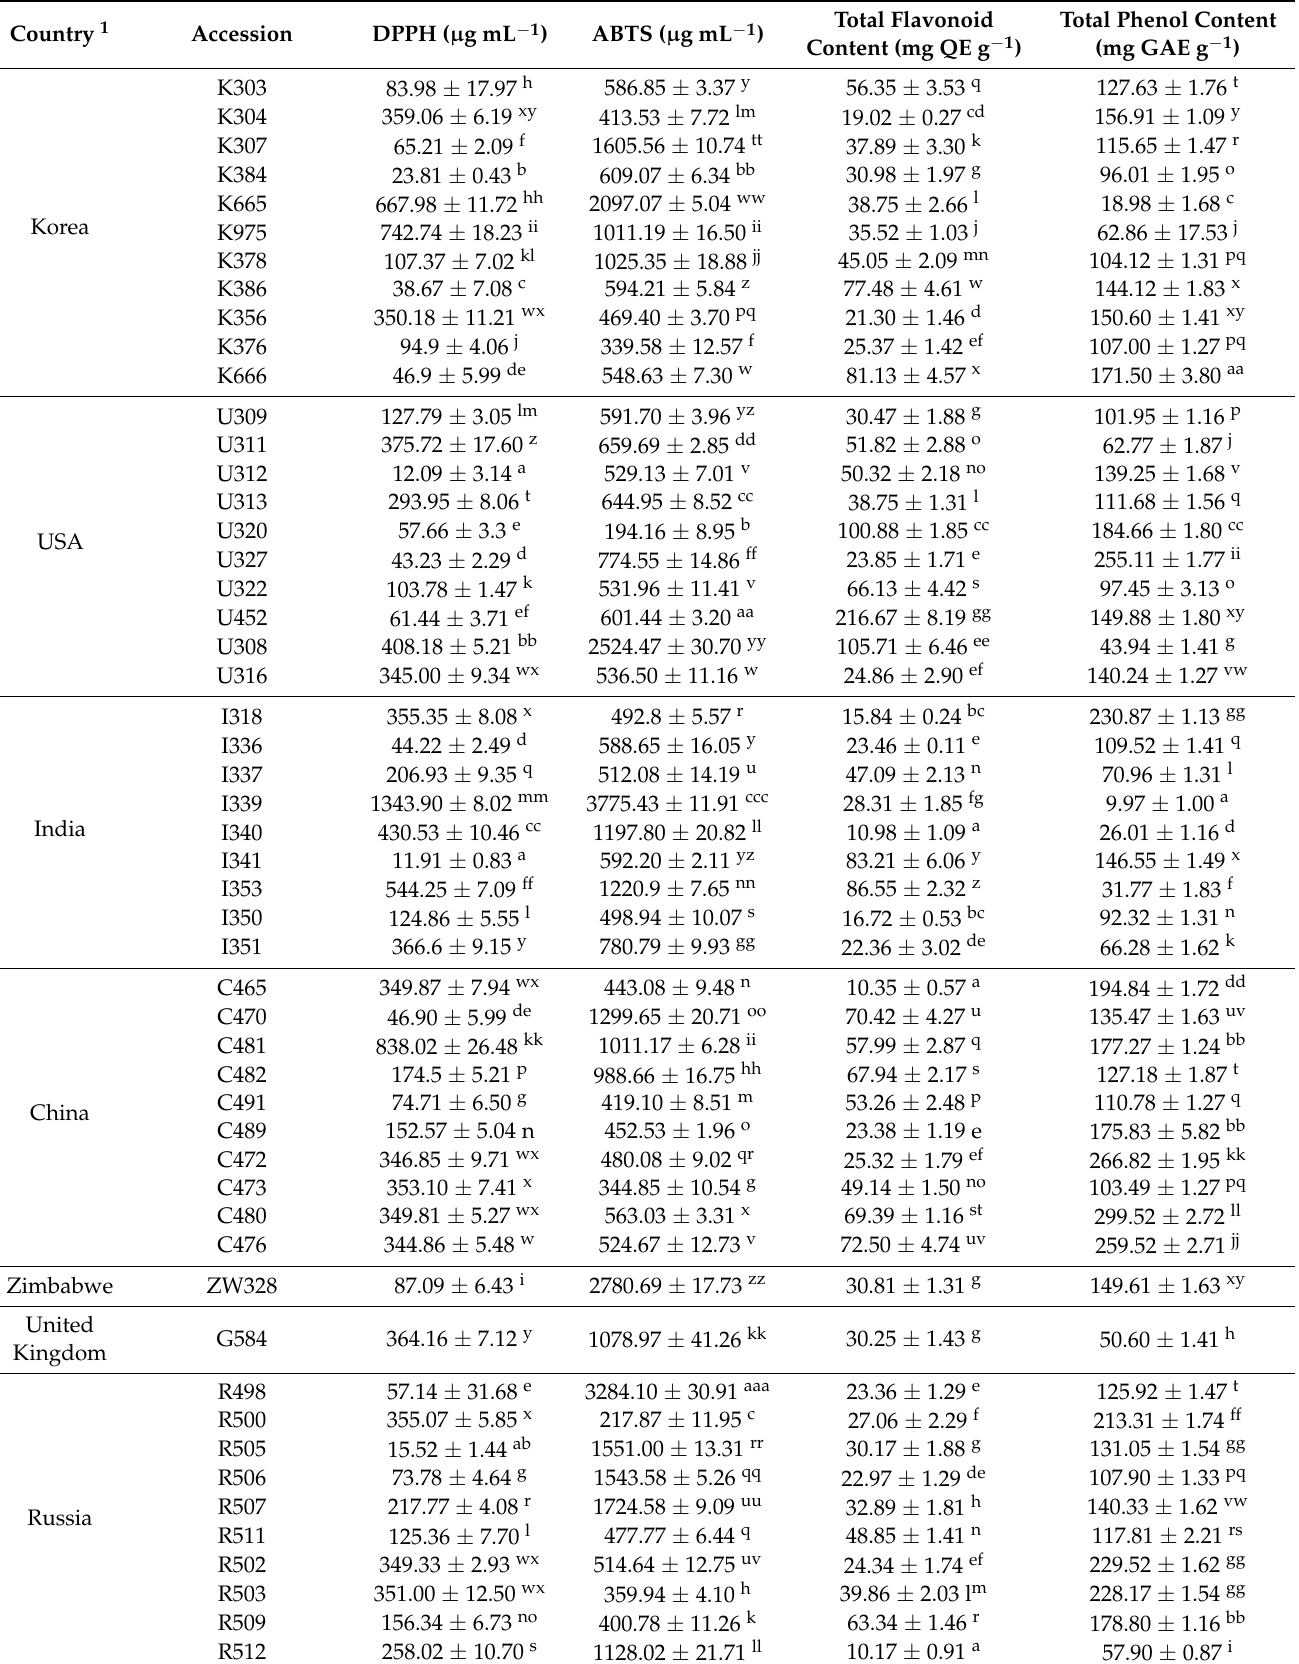
Table 2. Antioxidant activity, total phenolic and total flavonoid content of the selected S. bicolor accessions. Country